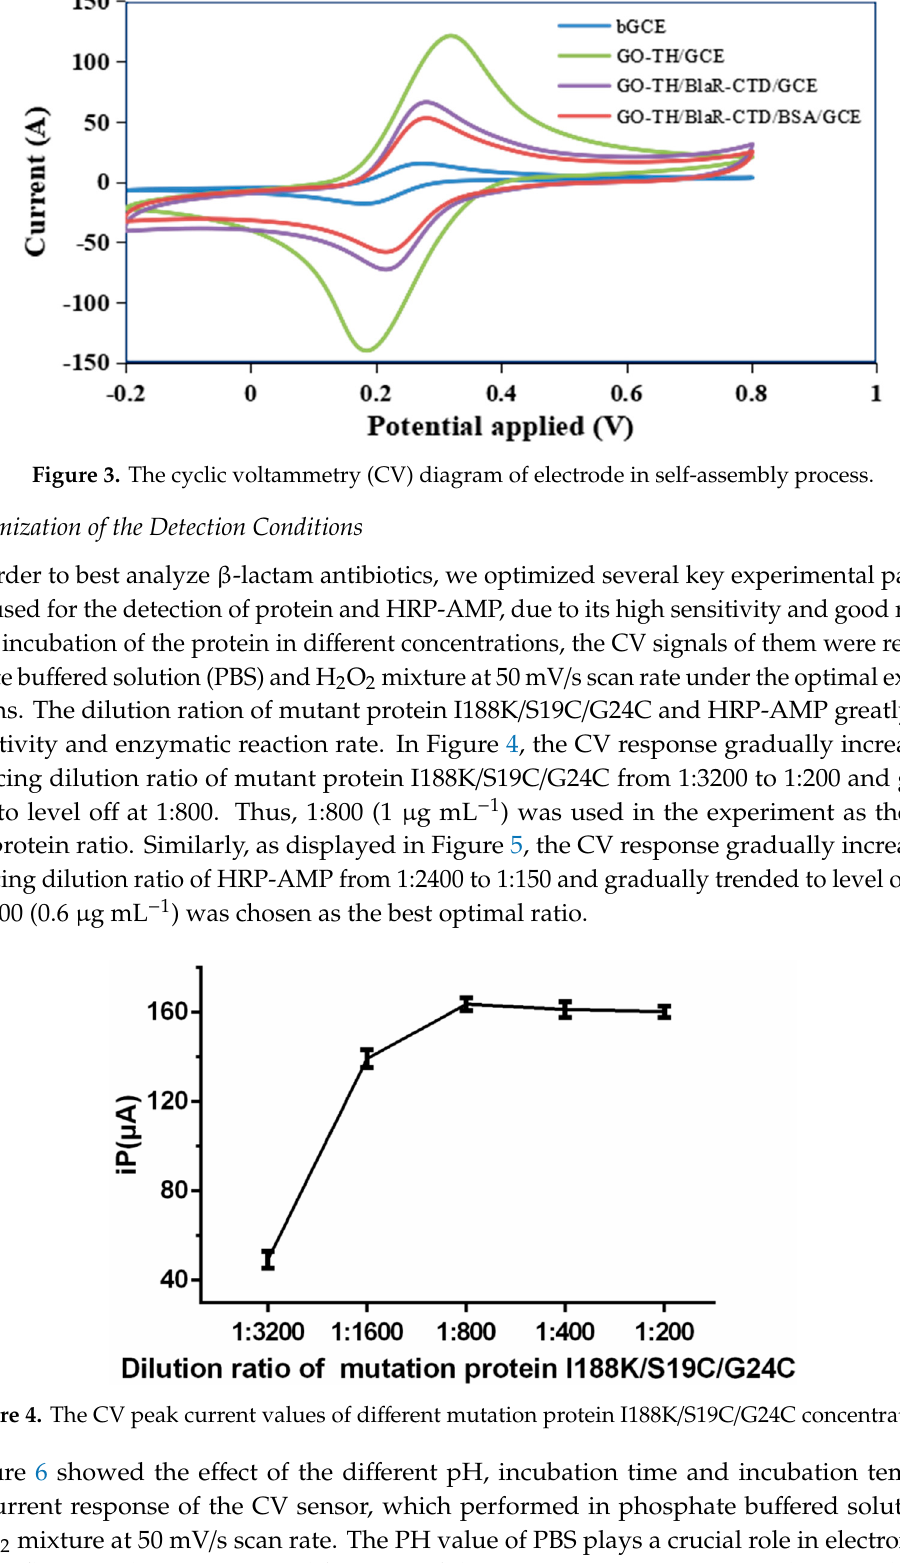
Figure 2. The electrochemical impedance spectroscopy (EIS) diagram of electrode in self-assembly process.